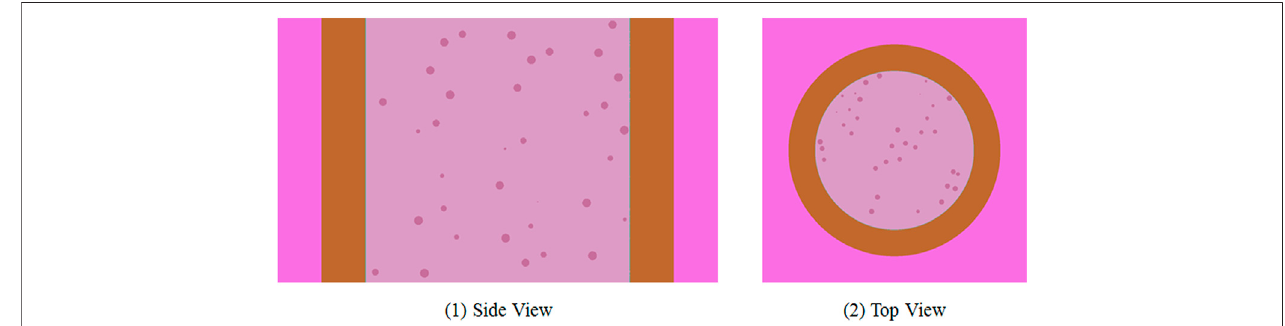
FIGURE 1 | Schematic diagram of random distribution of dispersed particles.